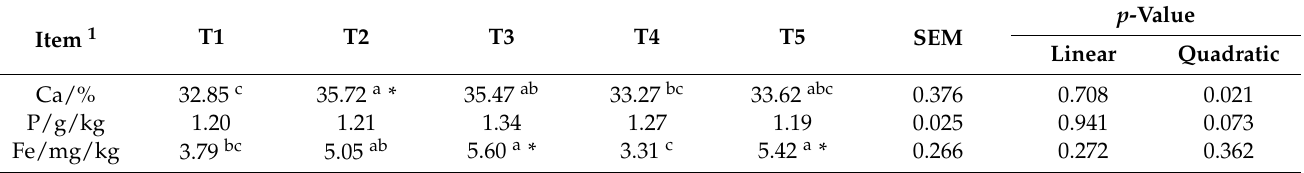
Table 7. Effect of casein phosphopeptide (CPP) on calcium, phosphorus, and iron content in